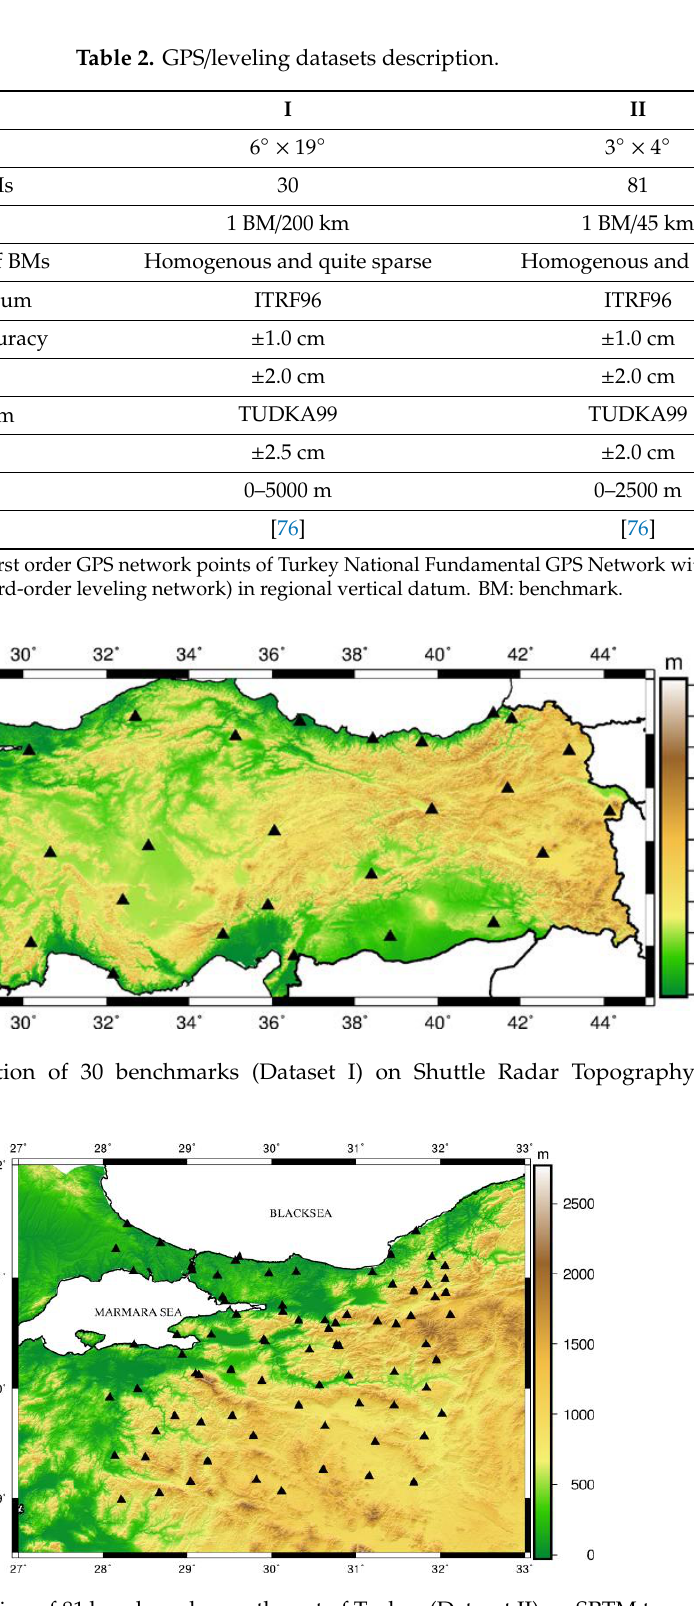
Figure 3. Distribution of 81 benchmarks, northwest of Turkey (Dataset II) on SRTM topography.